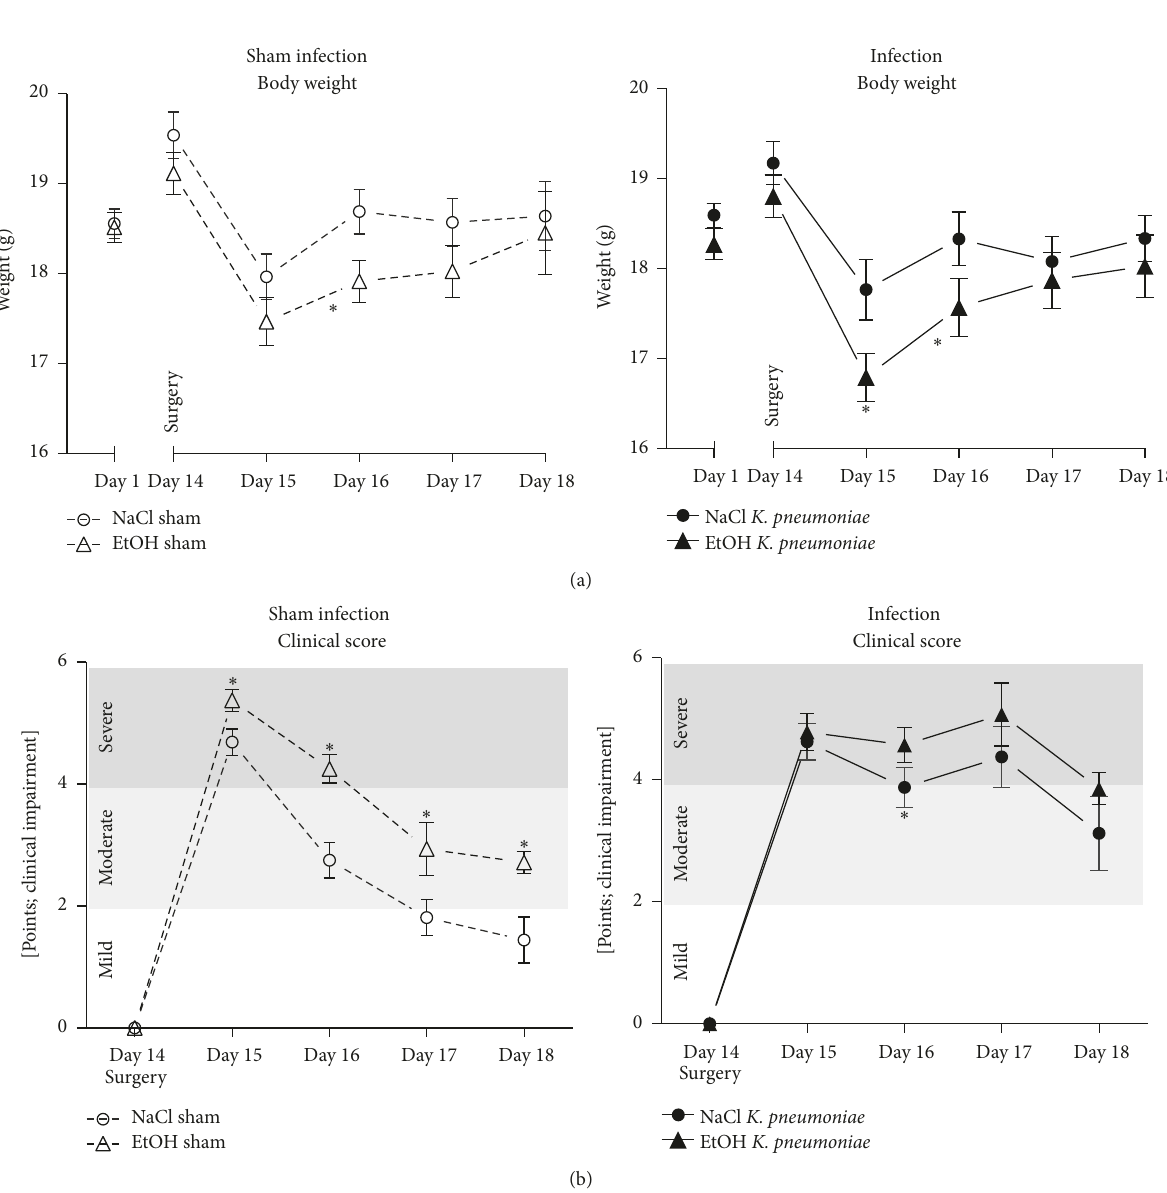
Figure 2: Analysis of body weight and clinical score in a murine model of ethanol exposition for 2 weeks, surgery, and pulmonary infection. (a) Development of body weight in sham-infected animals (left panel) and in animals with pulmonary infection with Klebsiella pneumoniae (right panel) over course of time in ethanol-treated (black/white triangle) and respective saline-treated controls (black circles/white circles). ∗ 𝑝 < 0.05 when compared to time-matched control group; data are presented as mean ± SEM, Mann–Whitney U test ( 𝑛 = 8 each group). (b) Development of clinical score in sham-infected animals (left panel) and in animals with pulmonary infection with Klebsiella pneumoniae (right panel) over course of time in ethanol-treated (black/white triangle) and respective saline-treated controls (black circles/white circles). For clinical scoring, motor activity, mucous membranes, and piloerection were assessed. For each item a score from zero to four points was given (0 points = no clinical impairment, 1 point = mild, 2 points = moderate, 3 points = moderate to severe, and 4 points = very severe impairment of the respective item). Clinical rating score was evaluated for each group. ∗ 𝑝 < 0.05 when compared to time-matched control group; data are presented as mean ± SEM, Mann–Whitney U test ( 𝑛 = 8 each group). ETOH: ethanol treatment; NaCl: saline-treated control; K . pneumoniae : pulmonary infection with Klebsiella pneumoniae